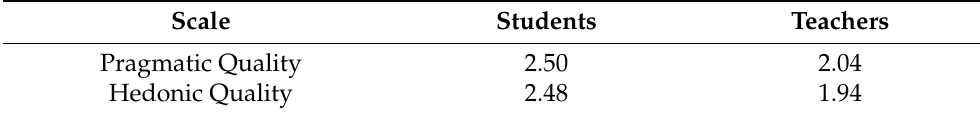
Table 4. Pragmatic and hedonic